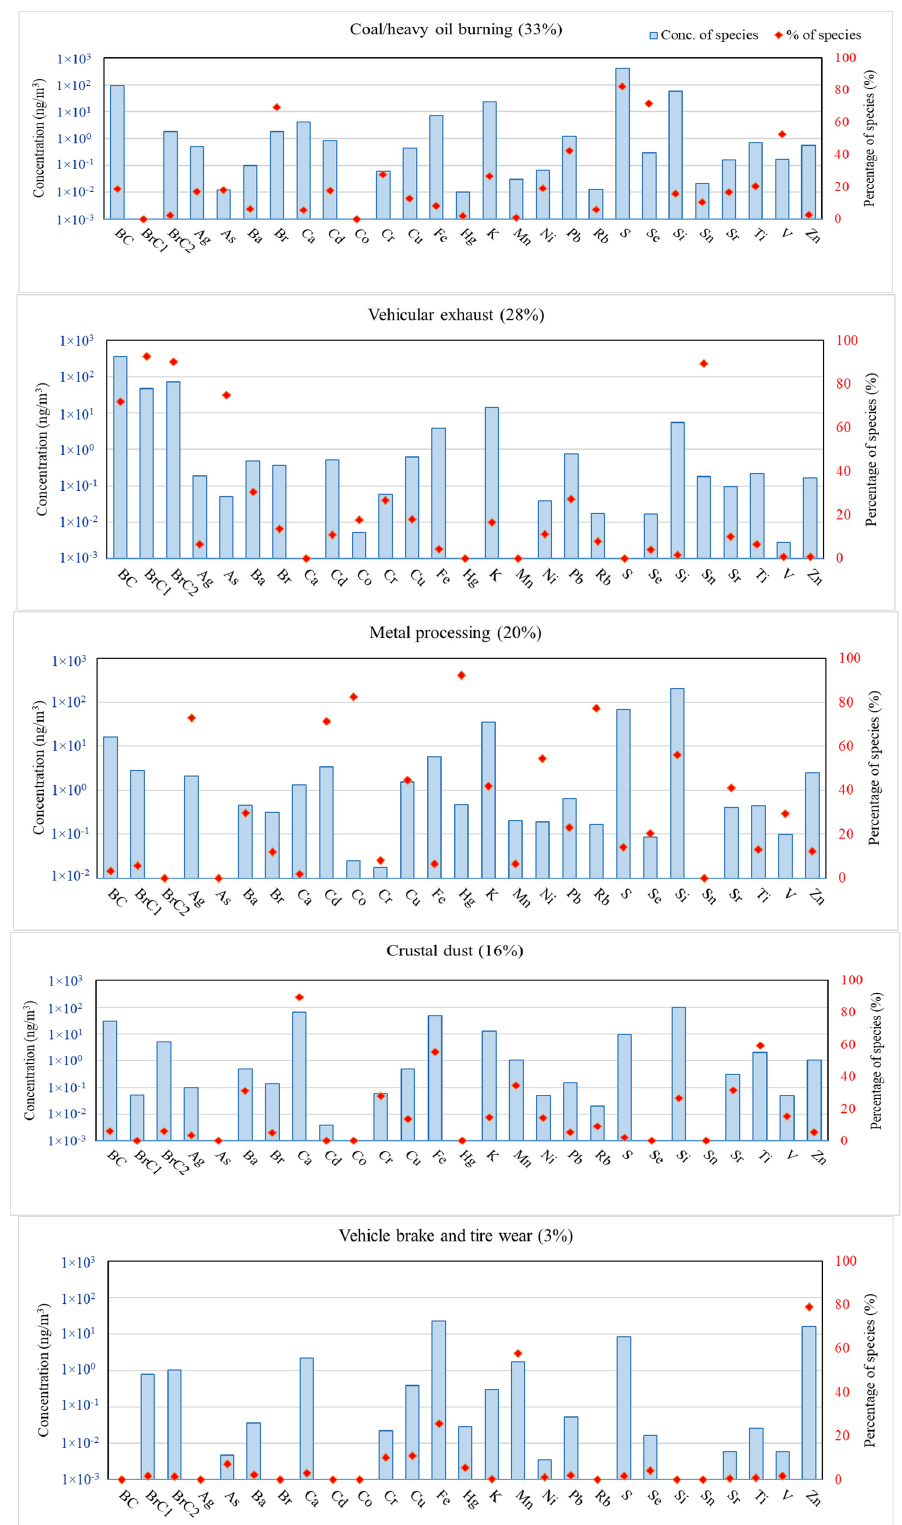
Figure 2. Profiles of five factors identified from the PMF model for BC, BrCs, and PM 2.5 -bound elements in Windsor during the study period. Percentage of species (diamond symbol) as the secondary Y-axis is the percentage of species mass concentrations being assigned to that factor. Percentages in the subtitles are average source